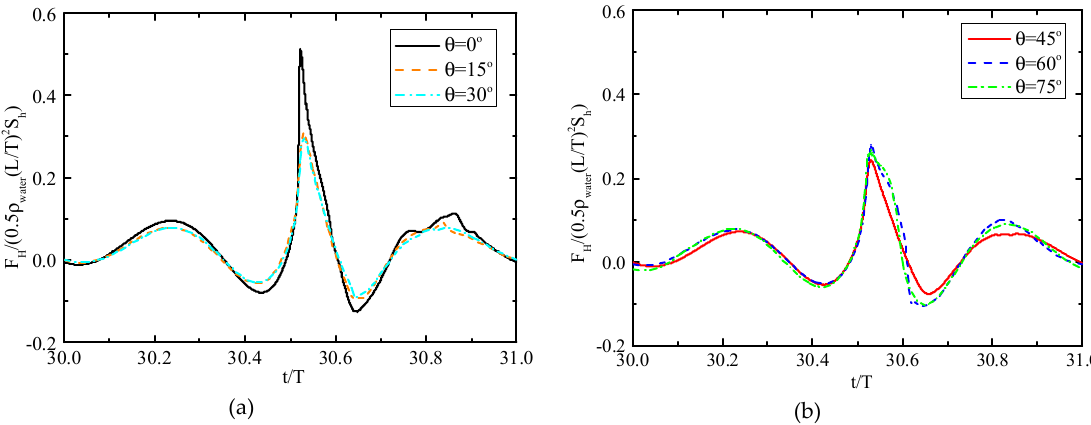
Figure 13. Variation of the normalized high-order wave forces on the cylinder in different transverse inclined angles. ( a ) θ = 0 ◦ , 15 ◦ , 30 ◦ ; ( b ) θ = 45 ◦ , 60 ◦ , 75 ◦